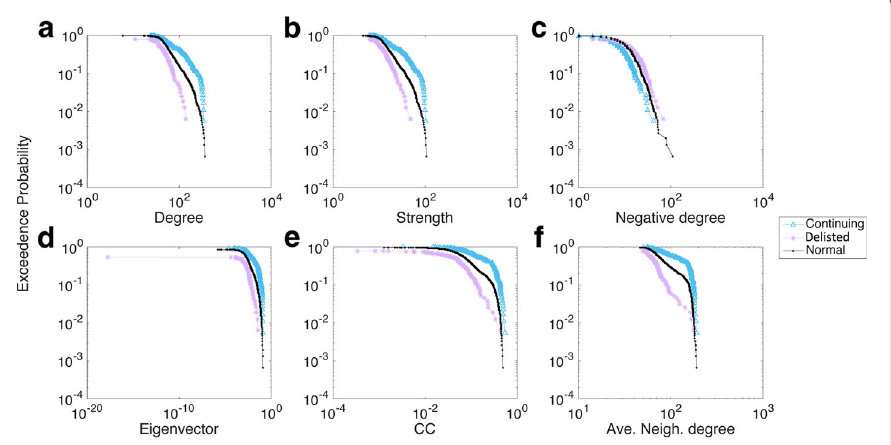
Fig. 8 Distribution of the six network measures in 2003-2004. a Degree; b Stength; c Negative degree; d Eigenvector; e CC; f Ave. Neigh.